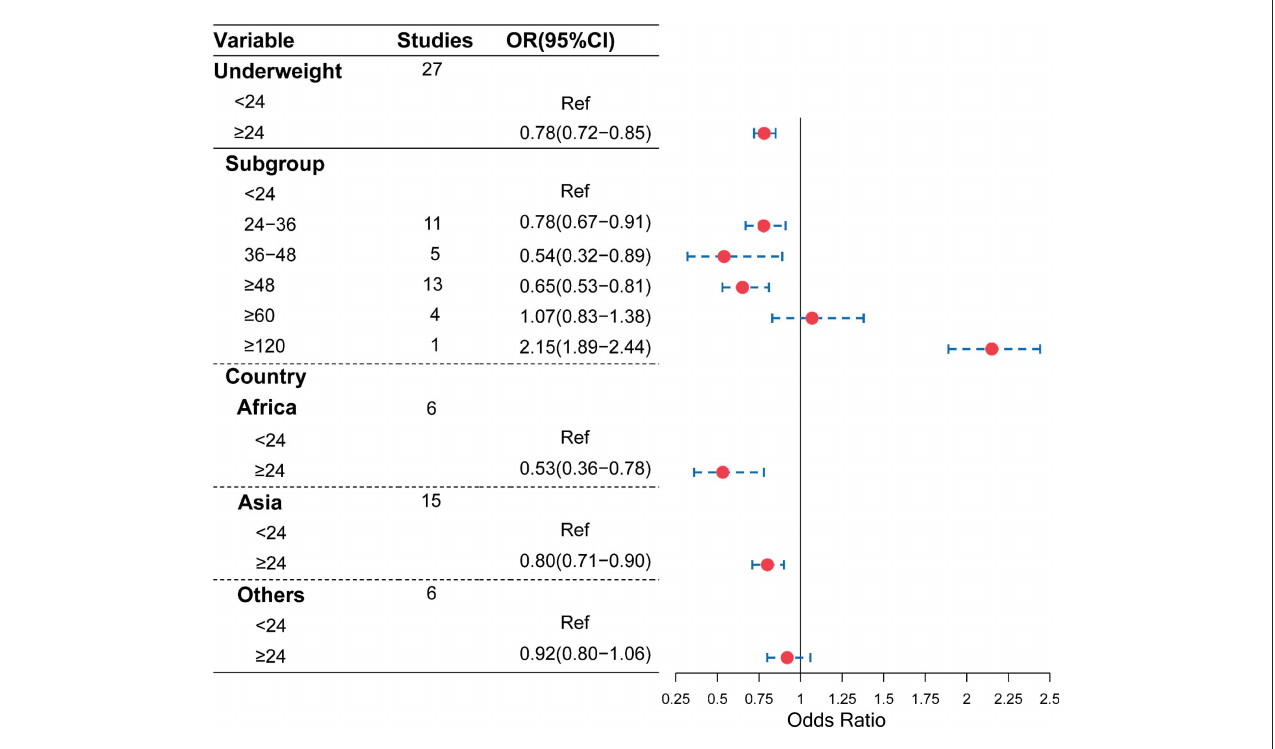
FIGURE2 Association of the birth interval and child underweight.